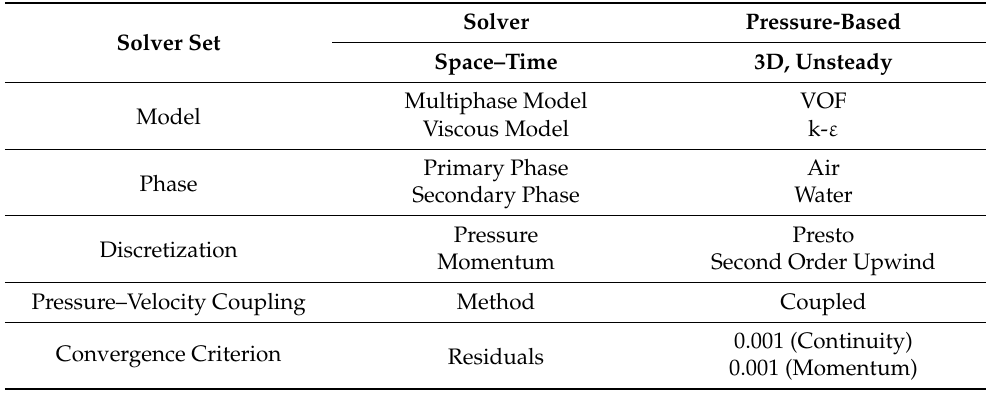
Table 3. Numerical model